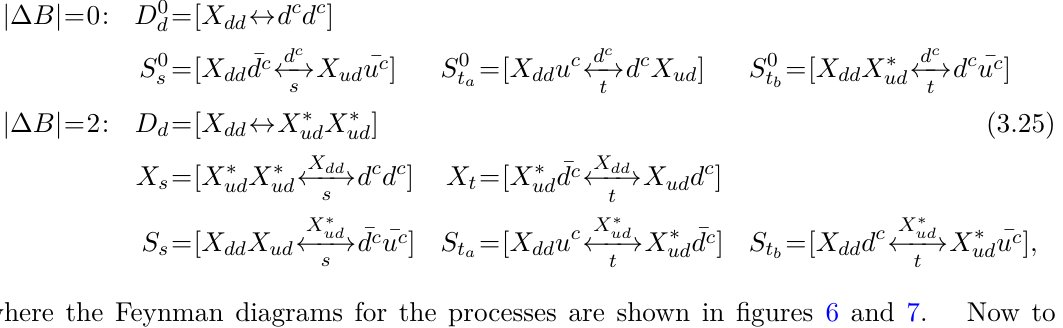
and r denotes /m 2 X dd X 0 dd